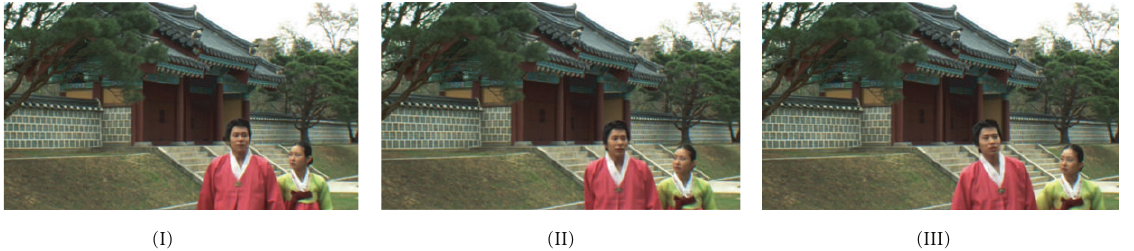
Figure 12: Images with di ff erent depth perception based on variation of near objects’ distance: Decreasing distance of near objects (from images I to III) creates a significant increase of depth perception.